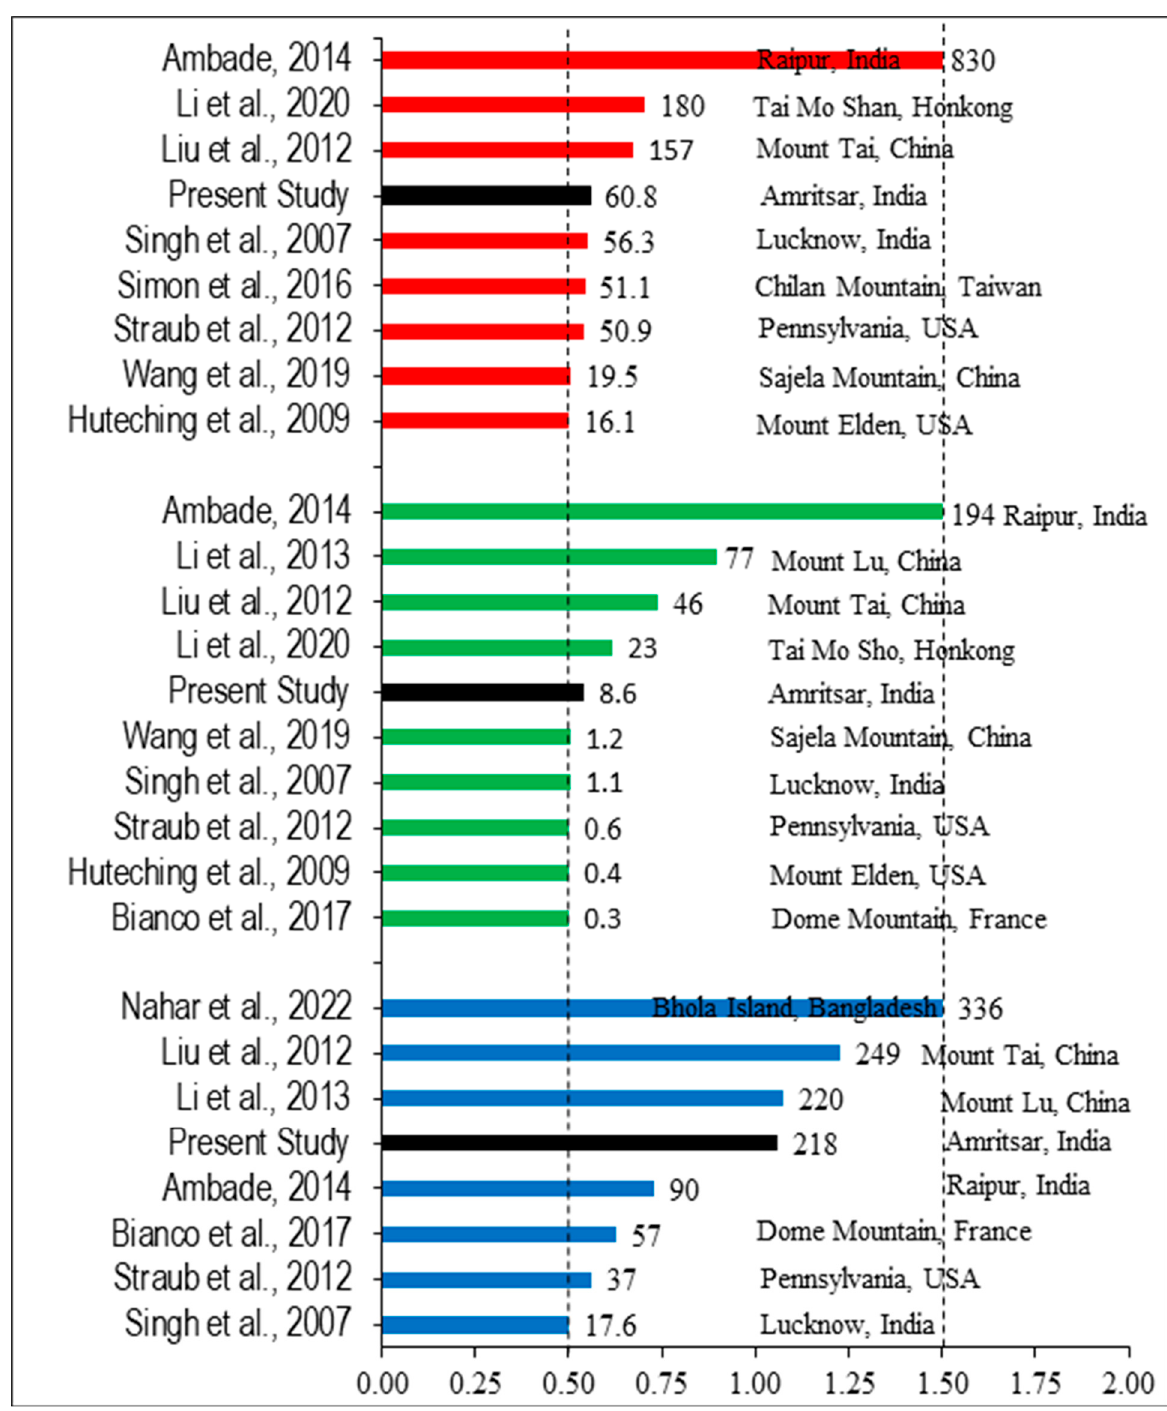
Figure 6. Review graph of metal concentrations (ppb) on normalized scale (0.5–1.5) for aluminum (red), lead (green) and zinc (blue) in fog water studies, (Black color represent own study). References included are [10–12,17,21,26,32,40,50,52,54].